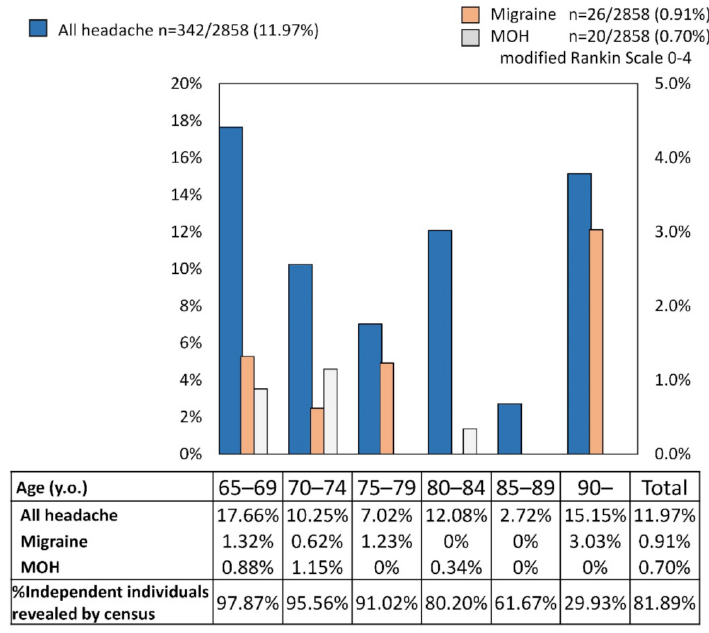
Figure 1. Age distribution of chronic headache, migraine, and medication overuse headache (MOH) in respondents aged over 64 with modified Rankin Scale